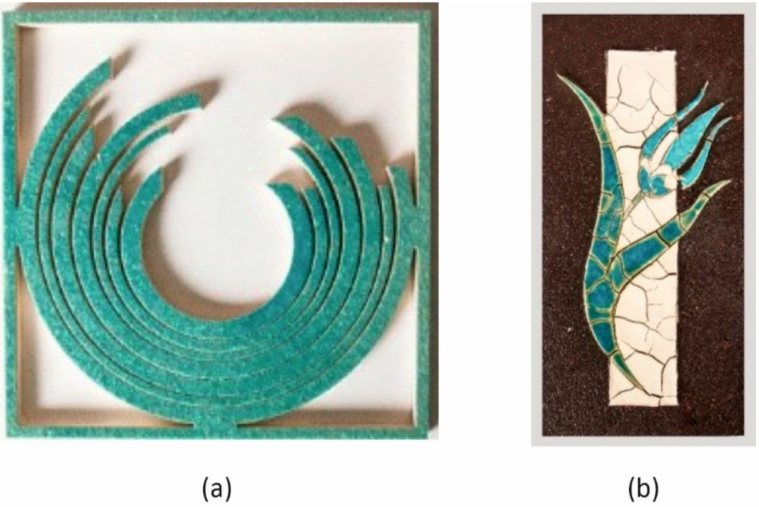
Figure 9. Artistic ceramics produced from marble waste by ( a ) pressing and ( b ) slip casting